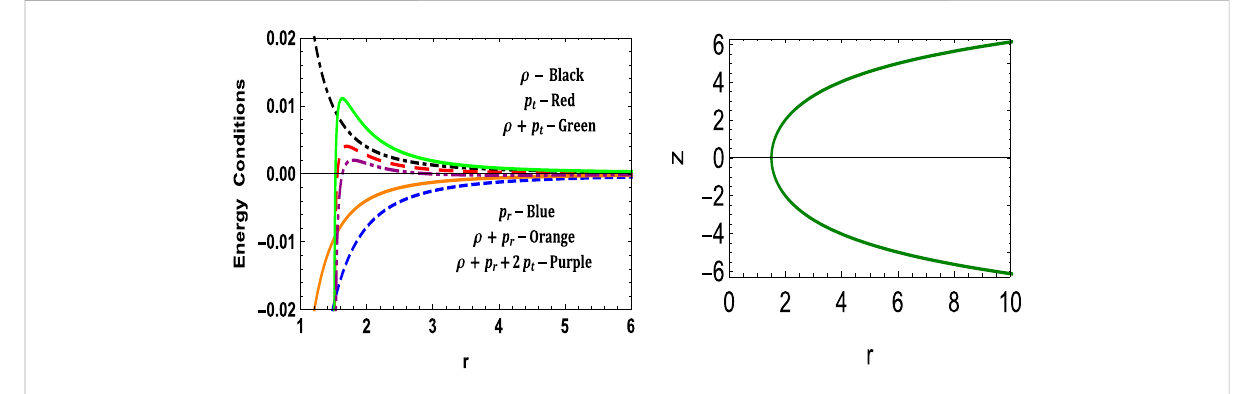
FIGURE 7 Variation of energy conditions and embedding surface for model III with a = 1.5, λ = 1.2, ω = − 2, c = 0.35.